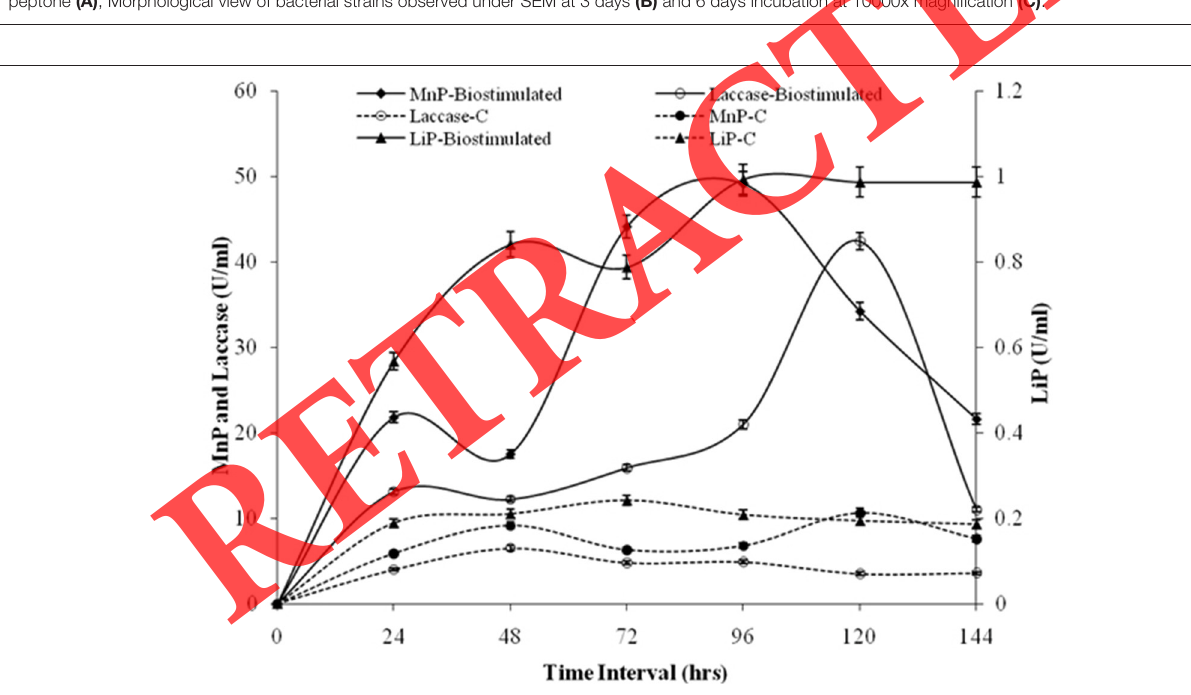
to the inhibitory effect on bacterial growth and their enzymatic activity. Therefore, the discharged effluent showed high